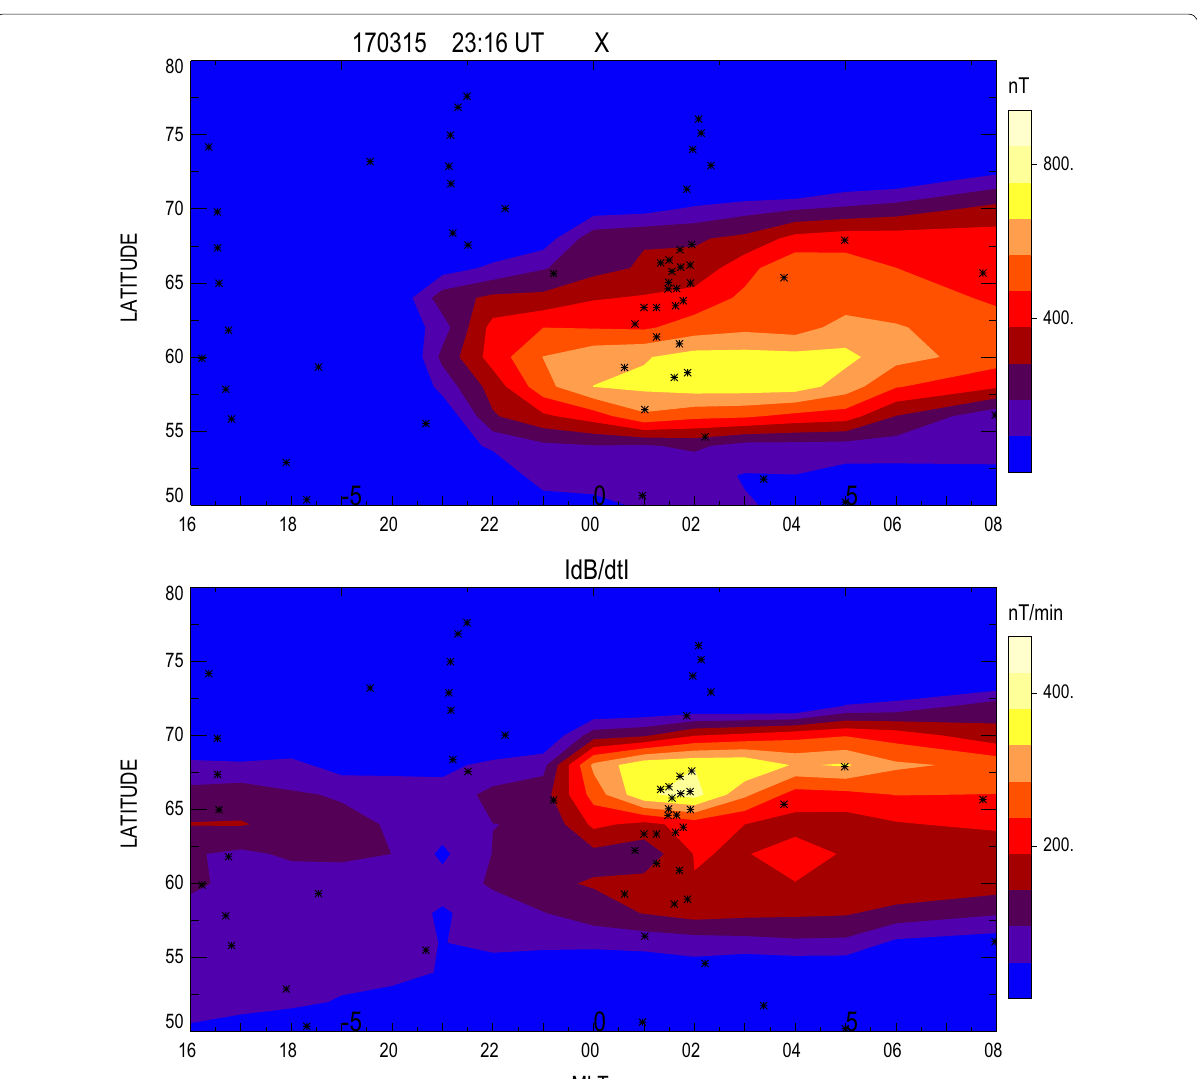
Fig. 5 Global Φ -LT maps for the time moment 2316 UT (substorm #6) of Δ X variations (upper panel), and magnetic variability |d B /d t | (bottom panel). No OVATION model data are available for this